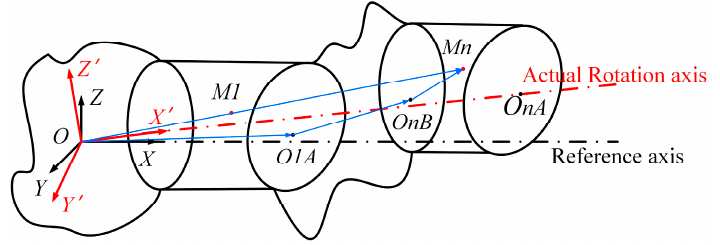
Figure 1. Multistage rotor centroid vector transformation model.